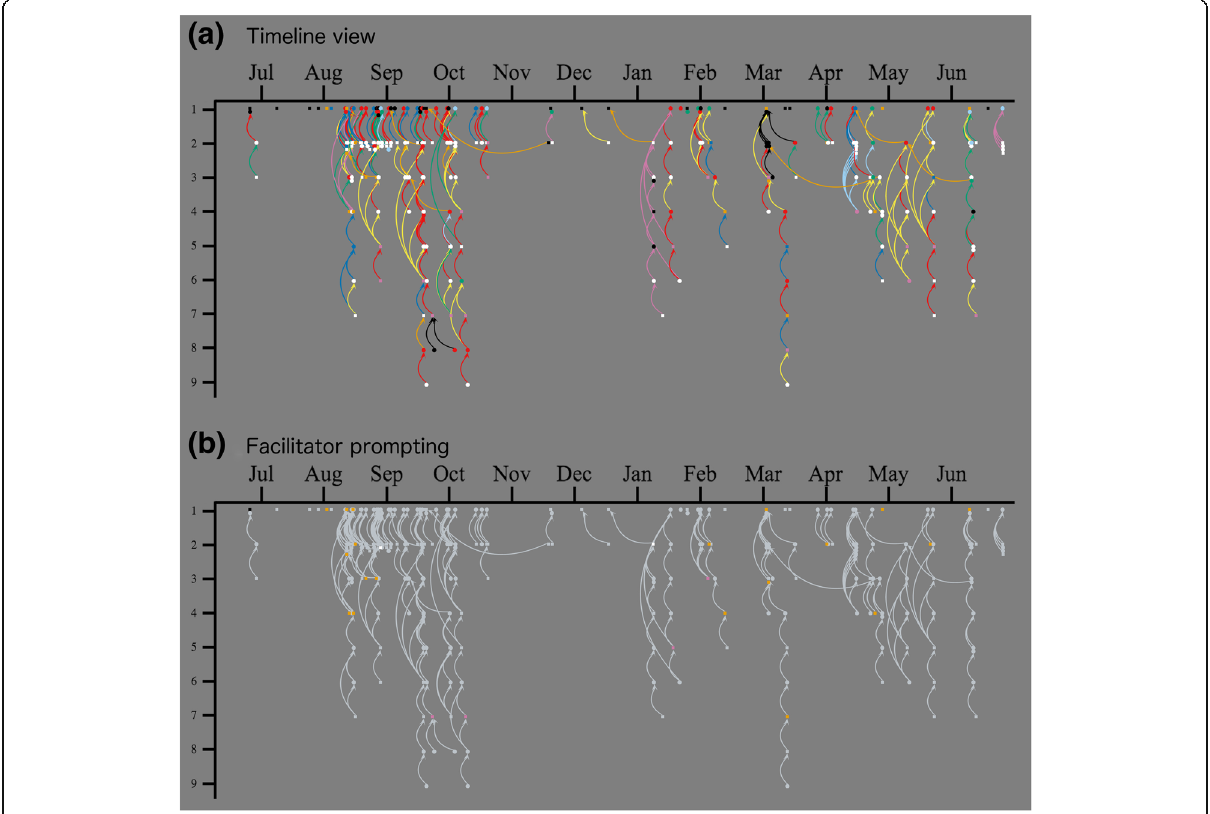
Fig. 8 a Timeline views of message networks, organized by level in conversation thread with b facilitator prompting